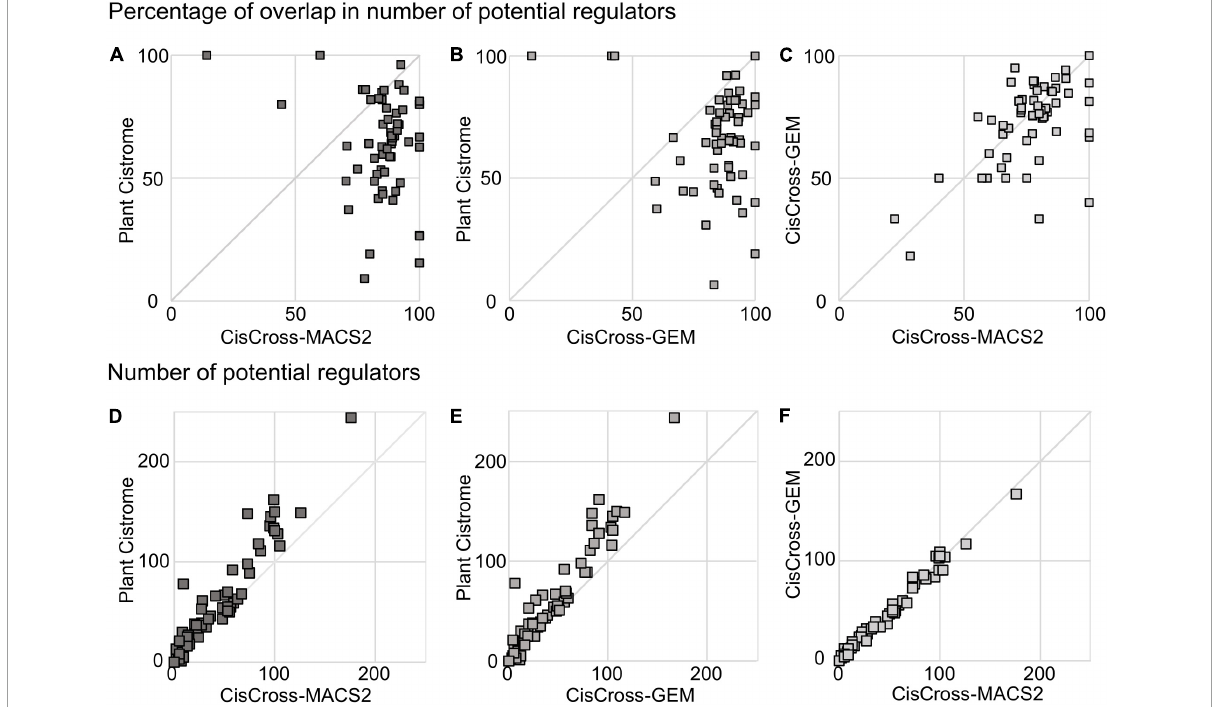
FIGURE3 Comparison of the results for the gene list enrichment analysis in pairwise combinations of different versions of the DAP-seq collection for the benchmark compilation of RNA-seq data from the EBI Expression Atlas (see section “Materials and methods”). Panels (A–C) show the percentage of overlap of the output lists for potential TF regulators (FDR < 0.05). Panels (D–F) show the total number of potential TF regulators (FDR < 0.05).